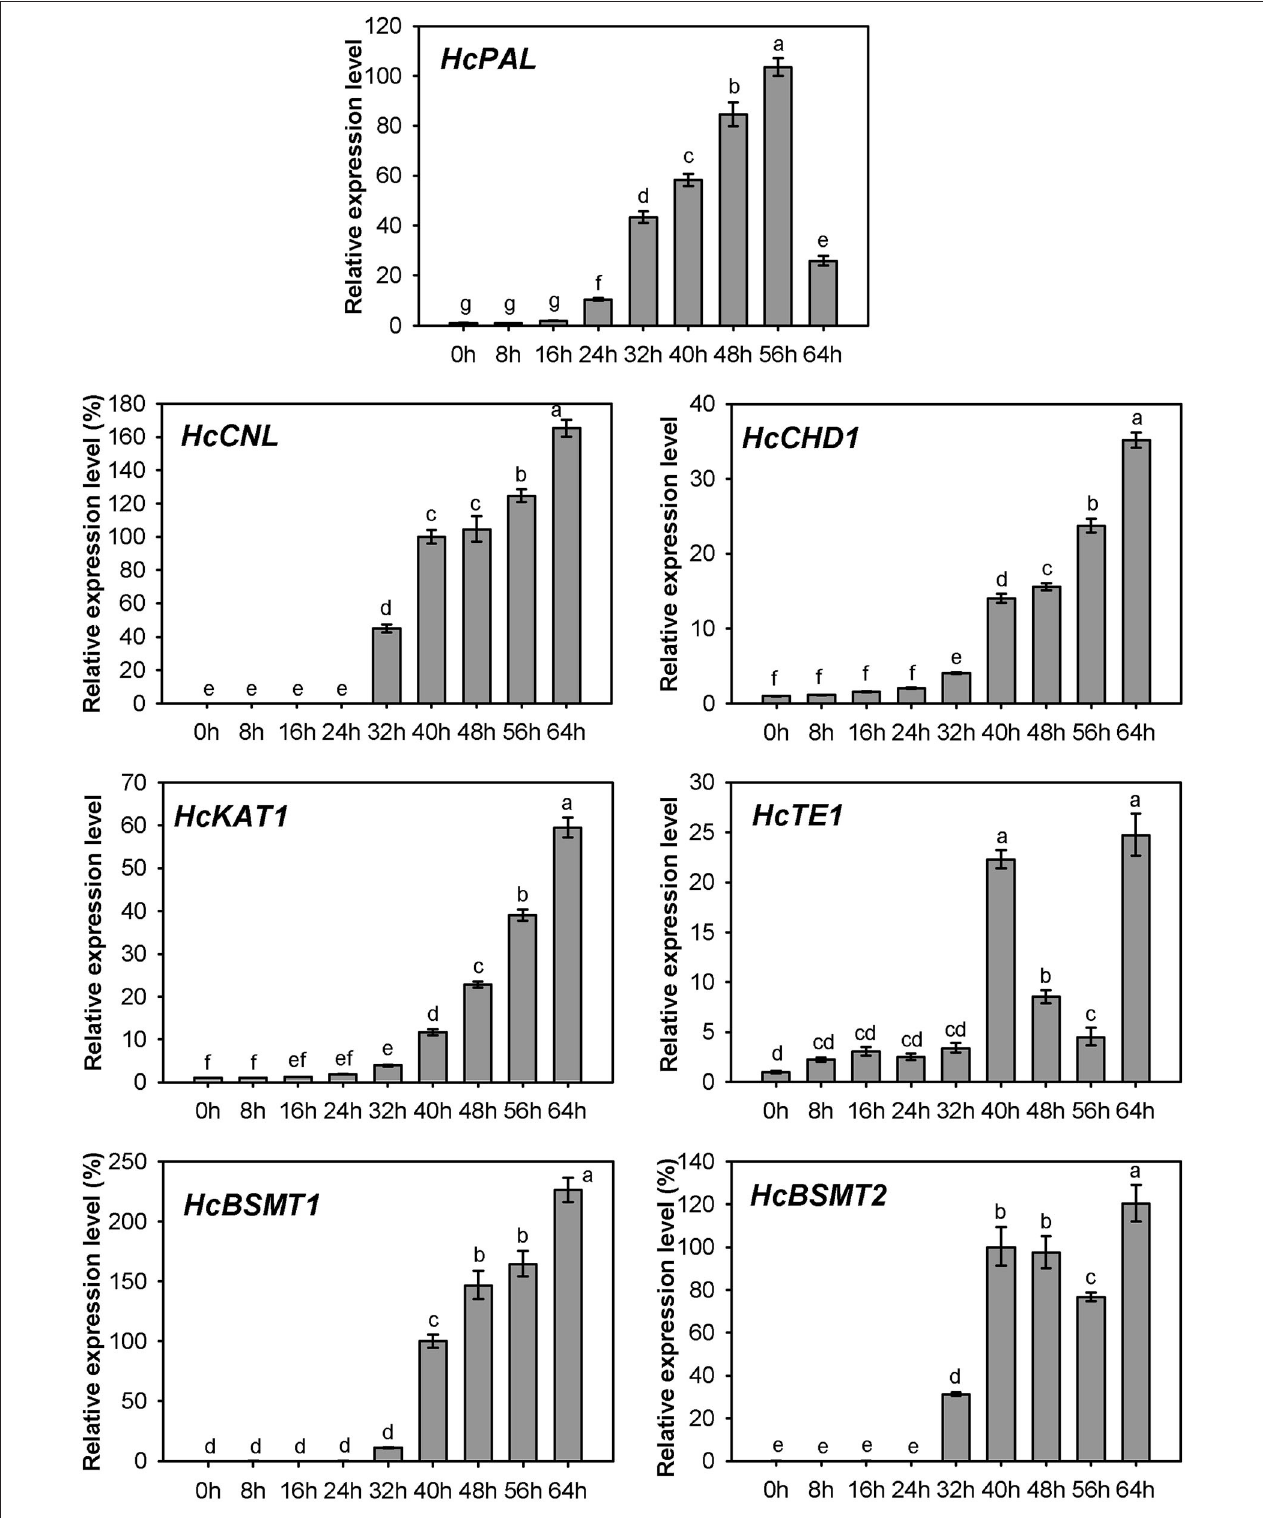
FIGURE 8 | Expression analysis of genes related to methyl benzoate biosynthesis in petals at different floral developmental stages. The relative expression quantity of 0h for HcPAL , HcCHD1 , and HcKAT1 and 40h for HcCNL , HcBSMT1 , and HcBSMT2 was set to 1 (100%). Error bars indicate the calculated maximum and minimum expression quantity of three replicates. Different lowercase letters labeled on bars indicate statistically significant differences at the level of P < 0.05.